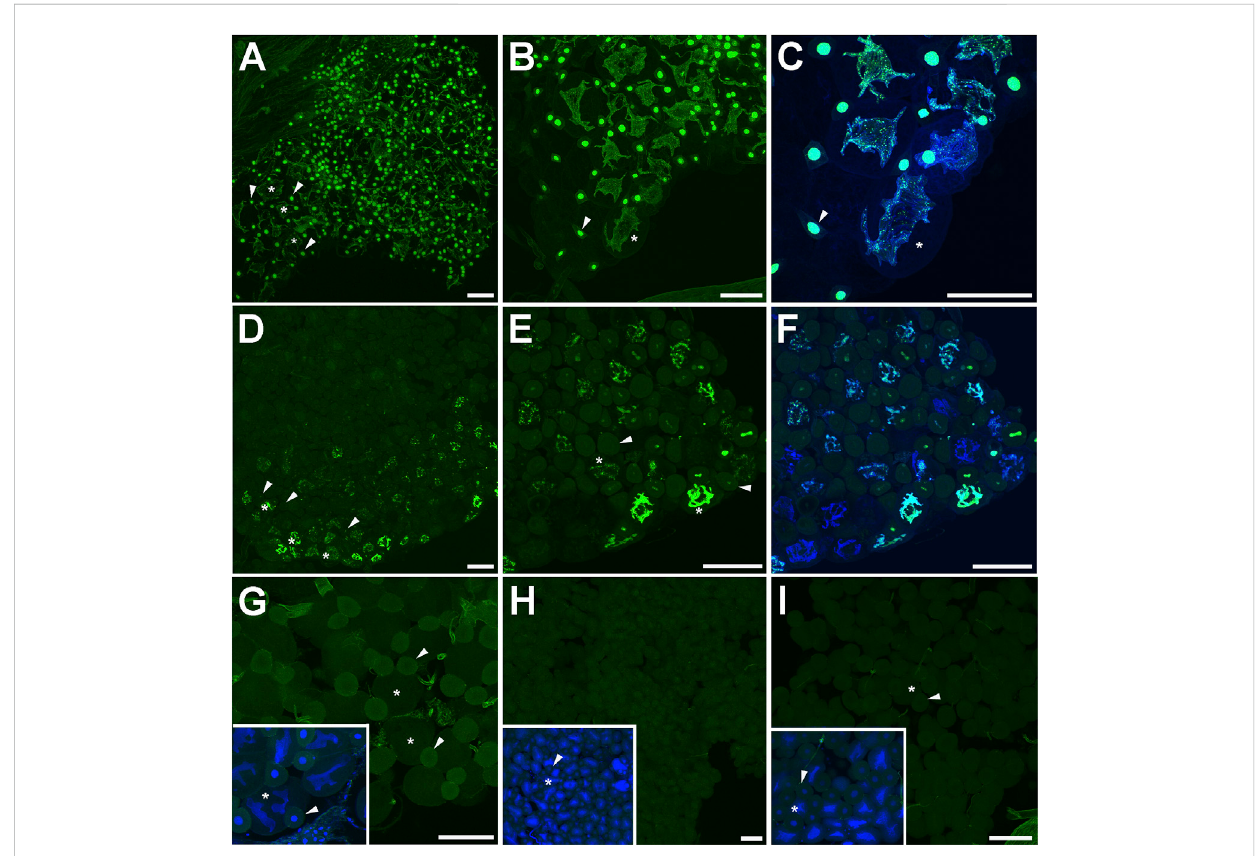
DNA synthesis in the abdominal fat body of bumblebee castes. (A – C) The dorsal – lateral part of the parietal fat body of 5- to 10-day-old virgin queens, (D – F) 1-year-old queens, (G) 15- to 20-day-old mated queens, (H) ovipositing workers, and (I) 1- to 3-week-old workers. The green color indicates localization of EdU incorporated during active DNA synthesis in nuclei. The green-blue color represents colocalization of EdU signals and DNA labelled by DAPI (blue). Asterisks point to adipocytes, and arrowheads show oenocytes. Scale bar 100